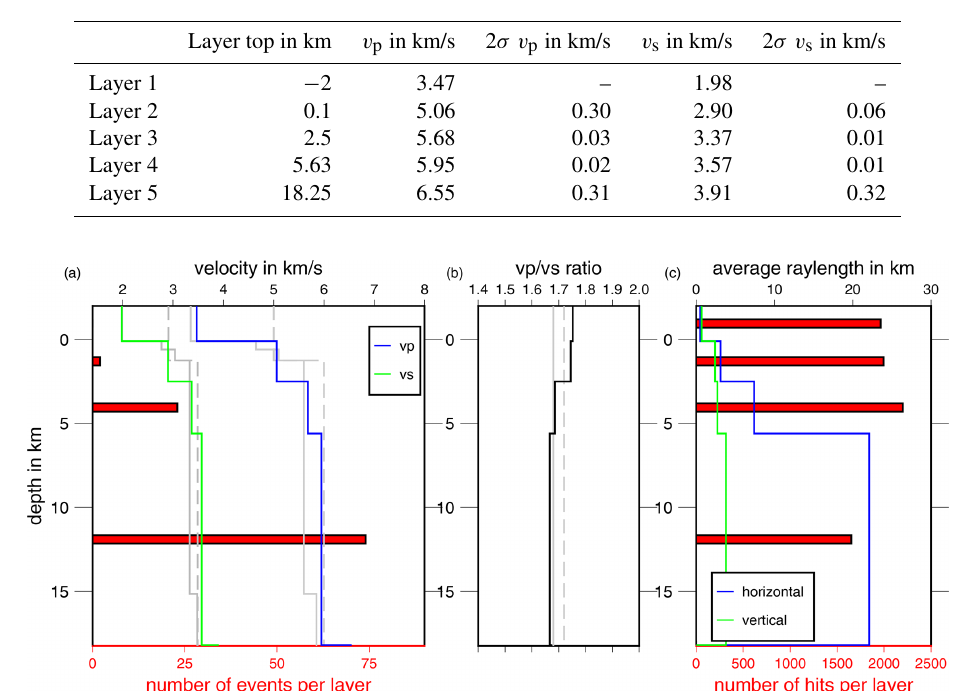
Figure 4. (a) Final minimum 1-D seismic velocity models (ASZmod1): v s is in green, and v p is in blue. Gray lines represent velocity models of the LED (Bulletin-Files des Landeserdbebendienstes B-W, 2018): solid lines show Swabian Jura models, and dashed lines show Baden- Württemberg models. Red bars are scaled with the number of events in each layer of the velocity model. (b) v p /v s ratio of ASZmod1 and the LED models. (c) Ray statistics of used ray paths. Red bars display number of hits per layer. Blue and green lines give the average horizontal and vertical ray